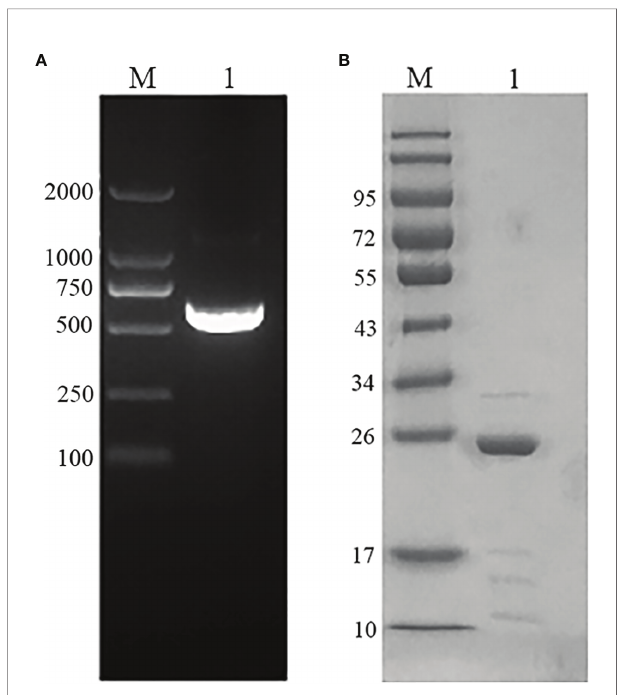
FIGURE 1 | Gene ampli fi cation and protein puri fi cation of EmARM- b . (A) Ampli fi cation of EmARM- b gene. M: DNA marker DL2000. Lane 1: the ampli fi ed EmARM- b gene from cDNA library. (B) Puri fi cation of recombinant protein EmARM- b detected by SDS-PAGE. M: protein mid-molecular weight marker. Lane 1: Puri fi cation of recombinant protein pET-28a-EmARM- b